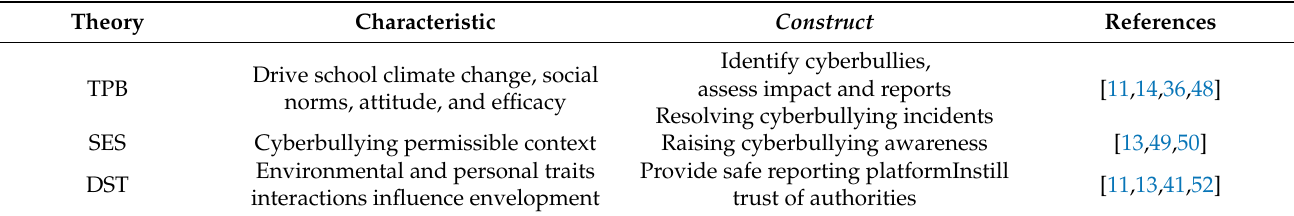
Table 1. Guiding theory